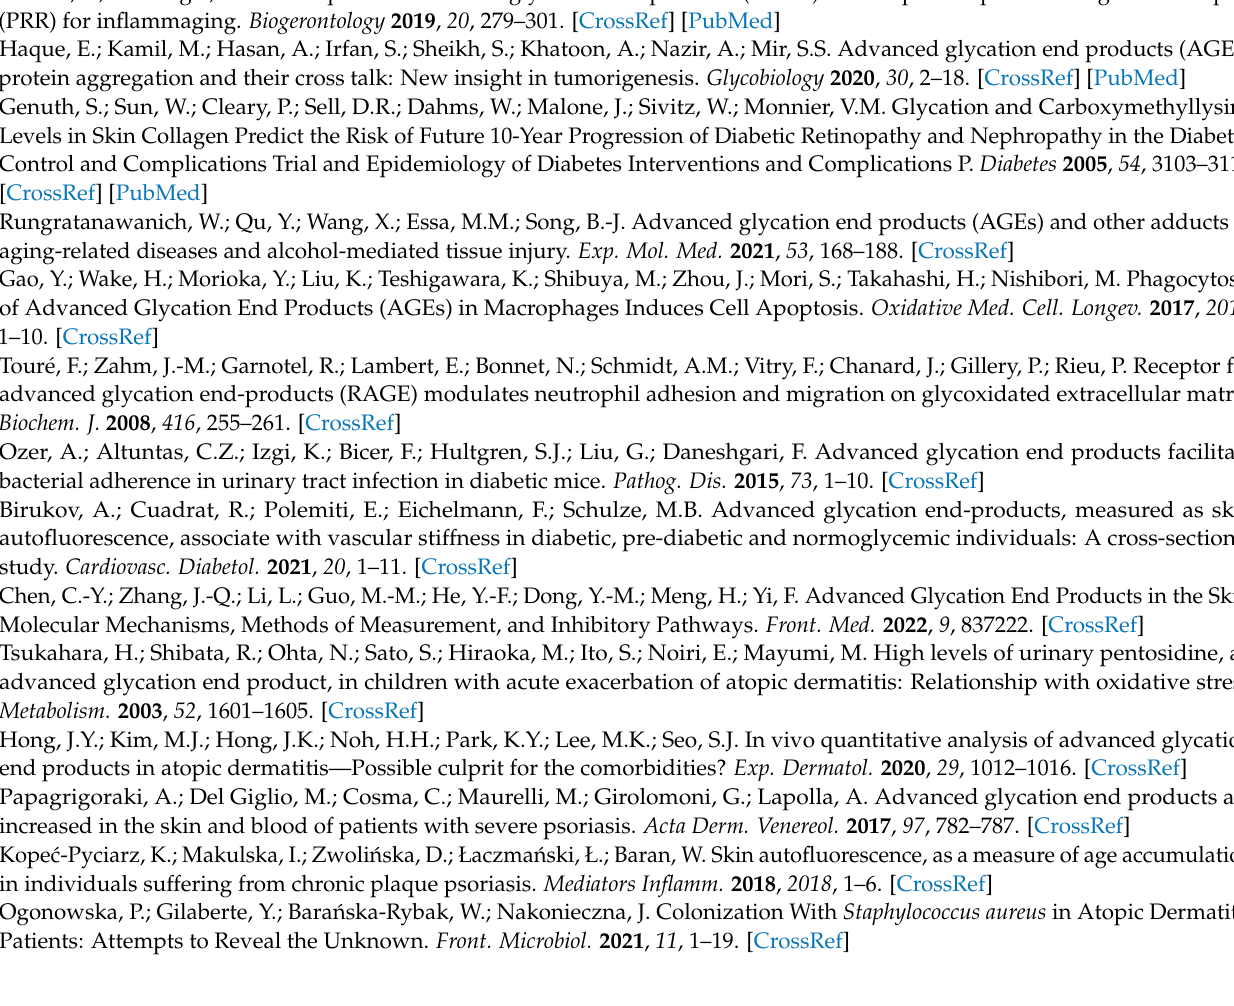
determined by Student’s t -test compared to control. *** p <